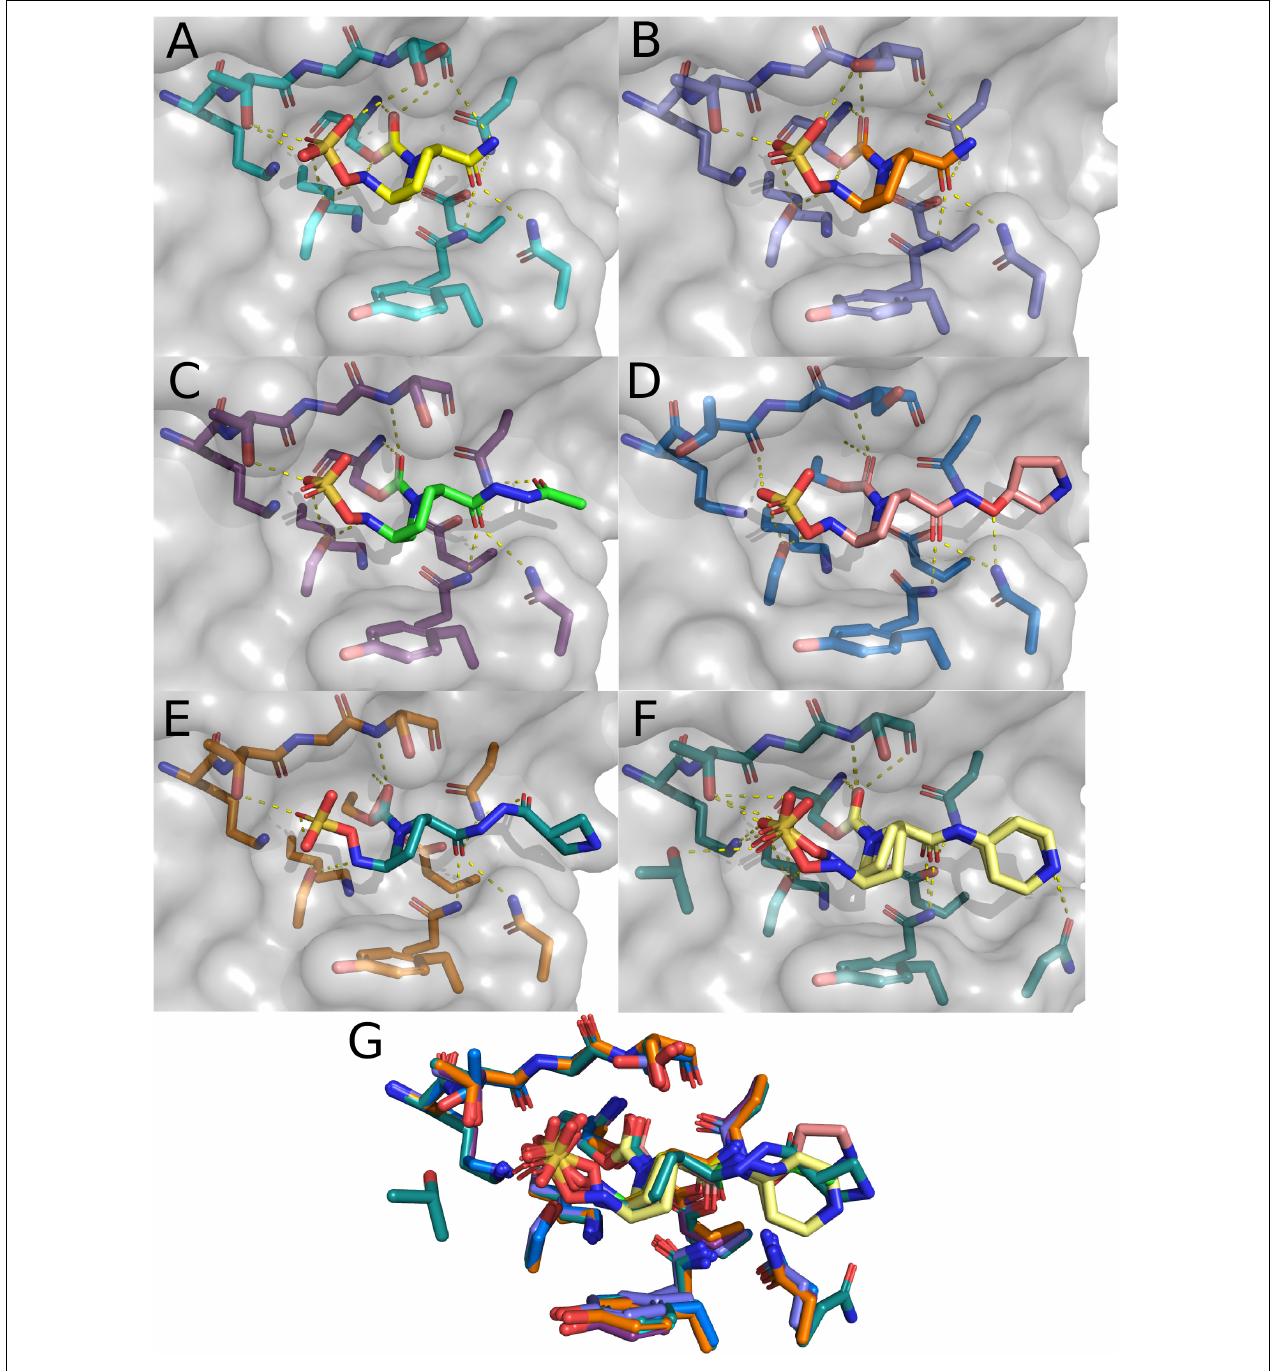
FIGURE 4 | CTX-M-15 structures in complex with DABCOs. (A) Structure of CTX-M-15 with bound Avibactam (4HBU). (B) Alternate structure of CTX-M-15 bound to Avibactam (4S2I). (C) Structure of CTX-M-15 and FPI-1523 (5FA7). (D) Structure of CTX-M-15 in complex with FPI-1465 (5FAO). (E) Structure of CTX-M-15 and FPI-1602 (5FAP). (F) Structure of CTX-M-15 in complex with Relebactam. (G) Overlay of active site residues of CTX-M-15 and all DABCO structures.